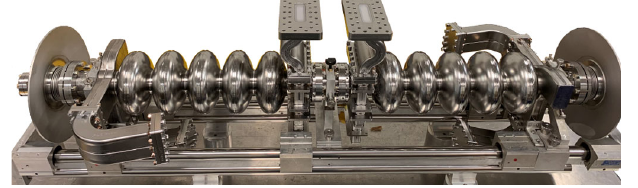
FIG. 8. C50 cavity pair assembled on a horizontal rail. The setup includes the doglegs with cold rf windows.